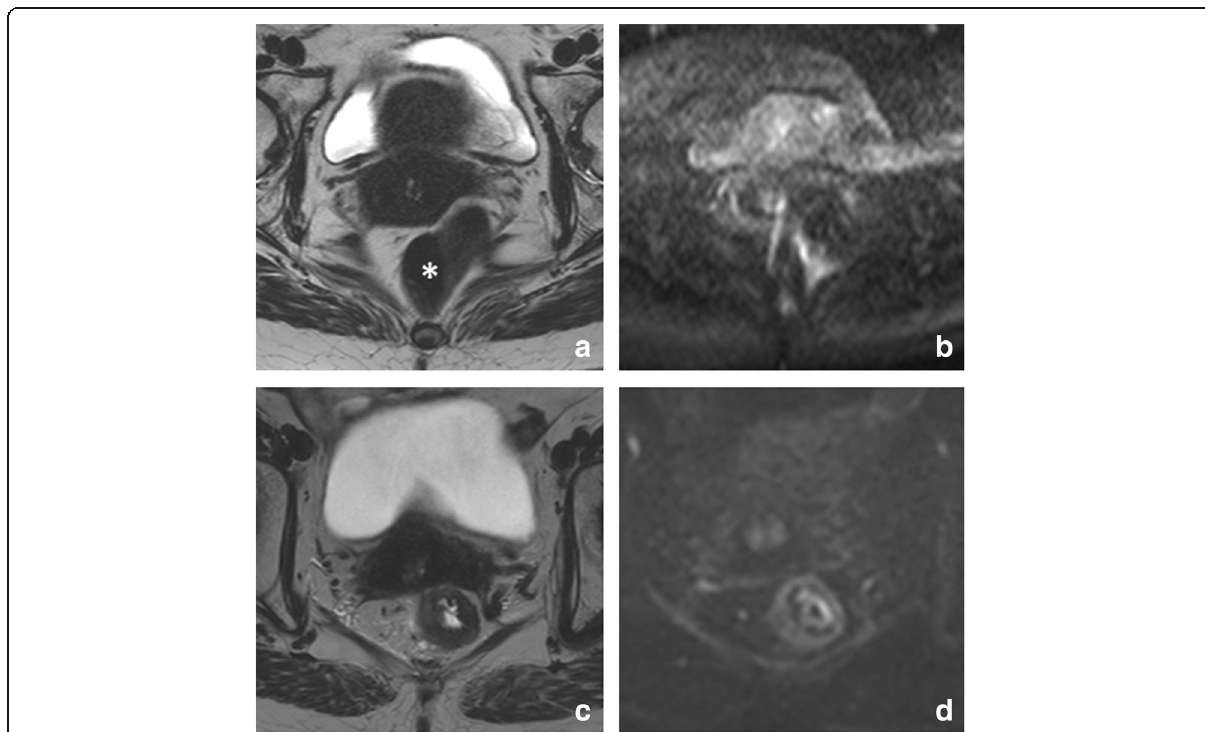
Fig. 1 Effect of preparatory micro-enema. MR images of the same patient performed without ( a T2-weighted; b b1000 diffusion-weighted) and with ( c T2-weighted; d b1000 diffusion-weighted) a preparatory micro-enema. The patient is a clinical complete responder, followed with MRI as part of a watch and wait-program. Note the severe distortions on DWI ( b ) caused by gas in the rectal lumen (* in a ). On the MRI performed after a preparatory micro-enema (self-administered by the patient 15 min before the MRI), there is no gas present in the rectum and the rectal wall is well discernible, both on T2-weighted and diffusion-weighted